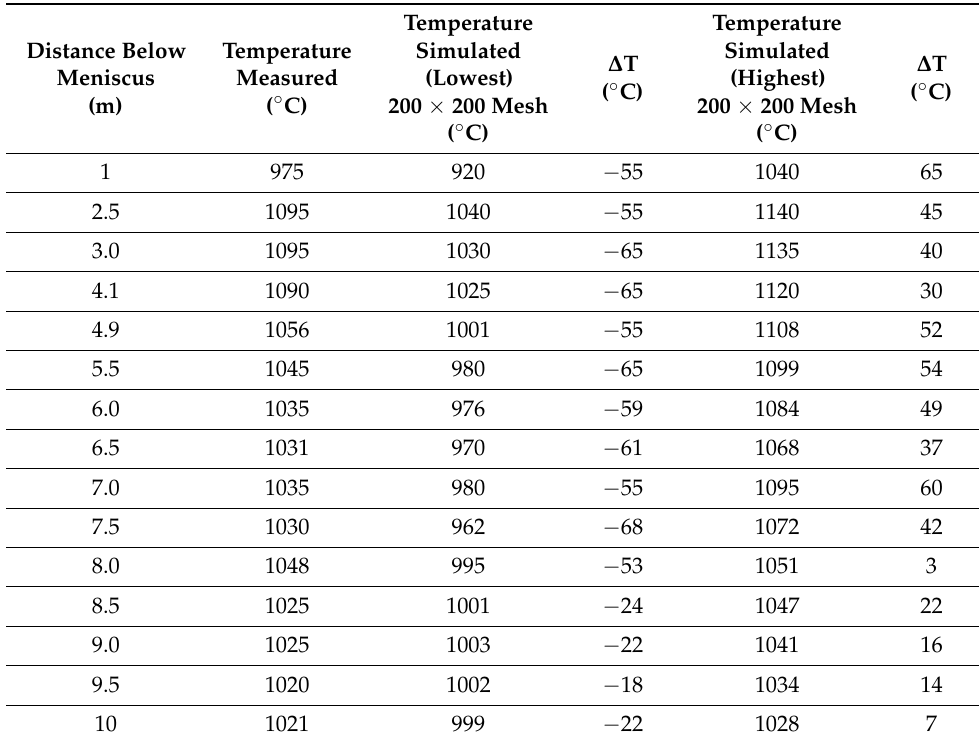
Table 10. Calculated errors for the simulated billets, case 2.